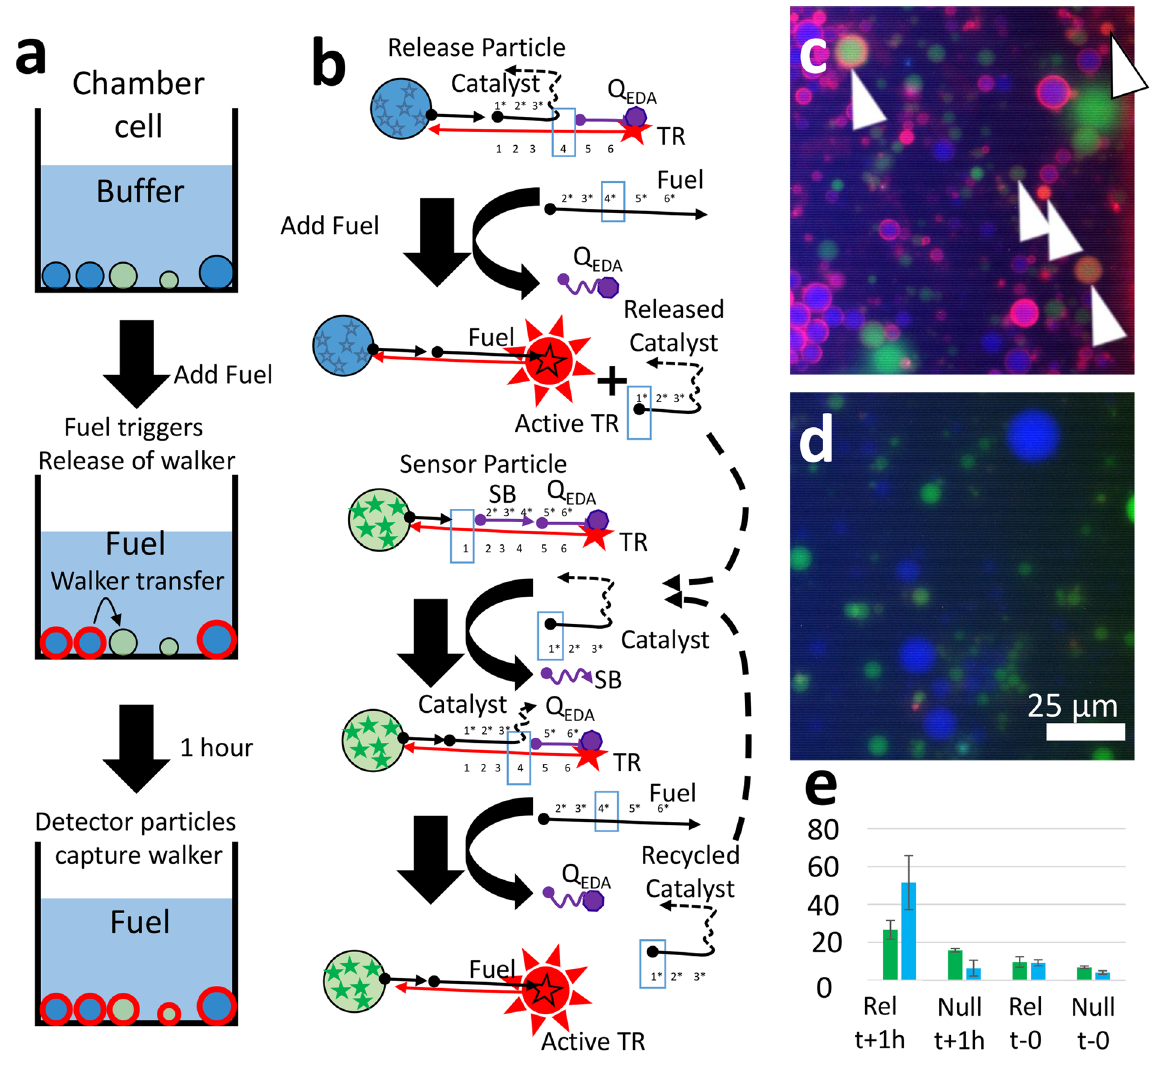
Figure 1. Demonstration of molecular walker release and capture. ( a ) A schematic shows the experimental steps for walker release and detection ( b ) A schematic shows how Cascade Blue dyed (blue) particles released the DNA walker in response to fuel; the DNA walker diffused to fluorescein-dyed (green) sensor particles and acted to de-quench Texas Red on their surfaces (arrows). ( c ) Fluorescence micrograph shows fluorescein dyed sensor particles and cascade blue release particles after incubation for 1 hour with fuel. ( d ) Fluorescence micrographs of the control system with blue particles bearing SB instead of the DNA walker after incubation for 1 hour with fuel. ( e ) Bar graph shows the average red fluorescence of the blue and green particles before and after addition of fuel from 8 or more images. Error bars represent the standard deviation of the particle